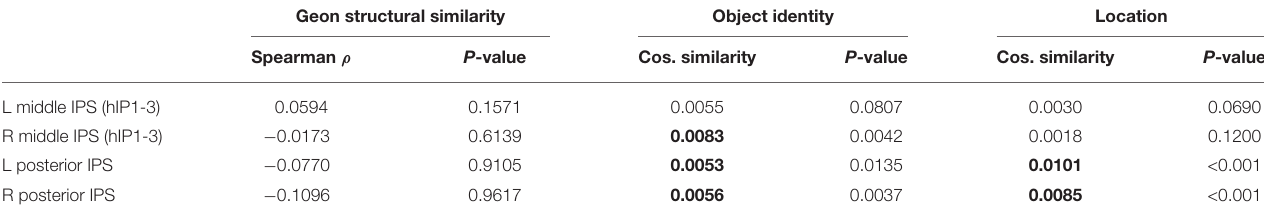
TABLE 8 | Geon experiment: cosine similarity (CS) for structural similarity, object identity and